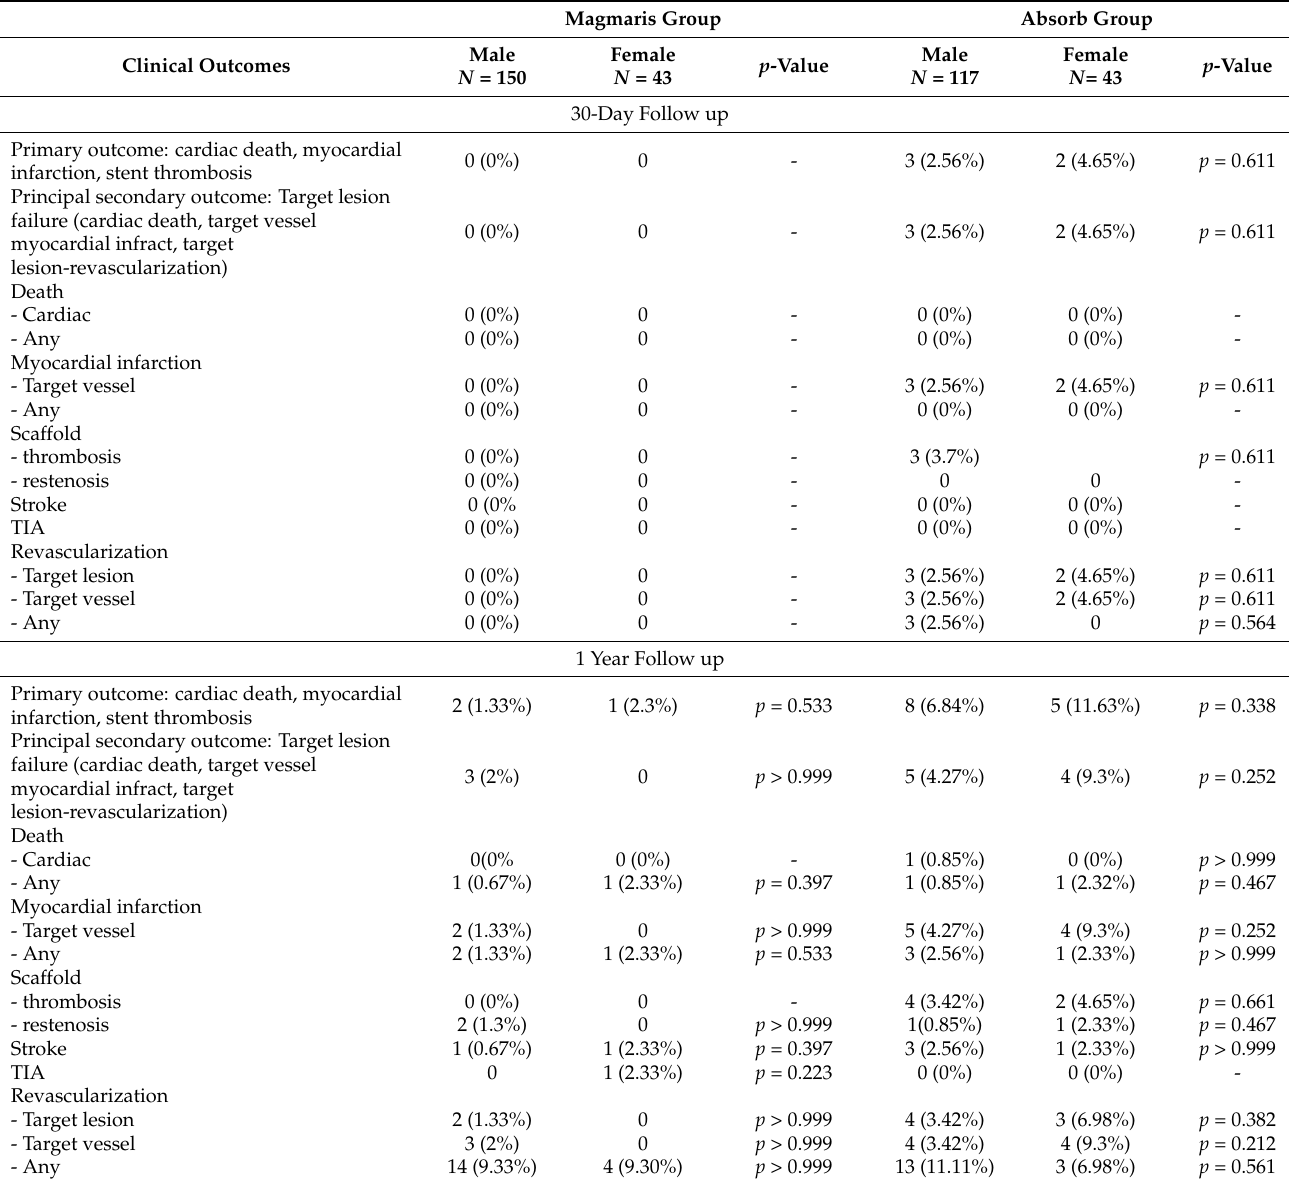
Table 3. Clinical outcomes in both study arms. Magmaris